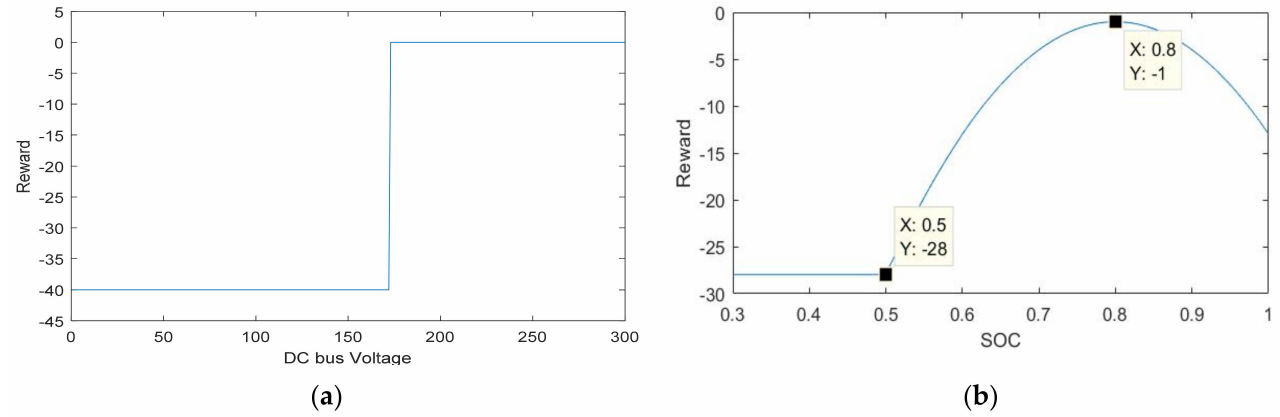
Figure 5. ( a ) Reward for DC bus voltage; ( b ) Reward for final battery